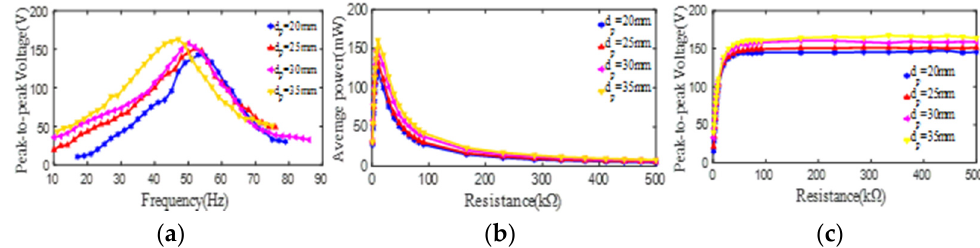
Figure 6. The effect of the inner diameter of the PZT4 patch on its peak-to-peak voltage and average power. ( a ) peak-to-peak voltage versus excitation frequency; ( b ) average power versus load resistance; ( c ) peak-to-peak voltage versus load resistance.